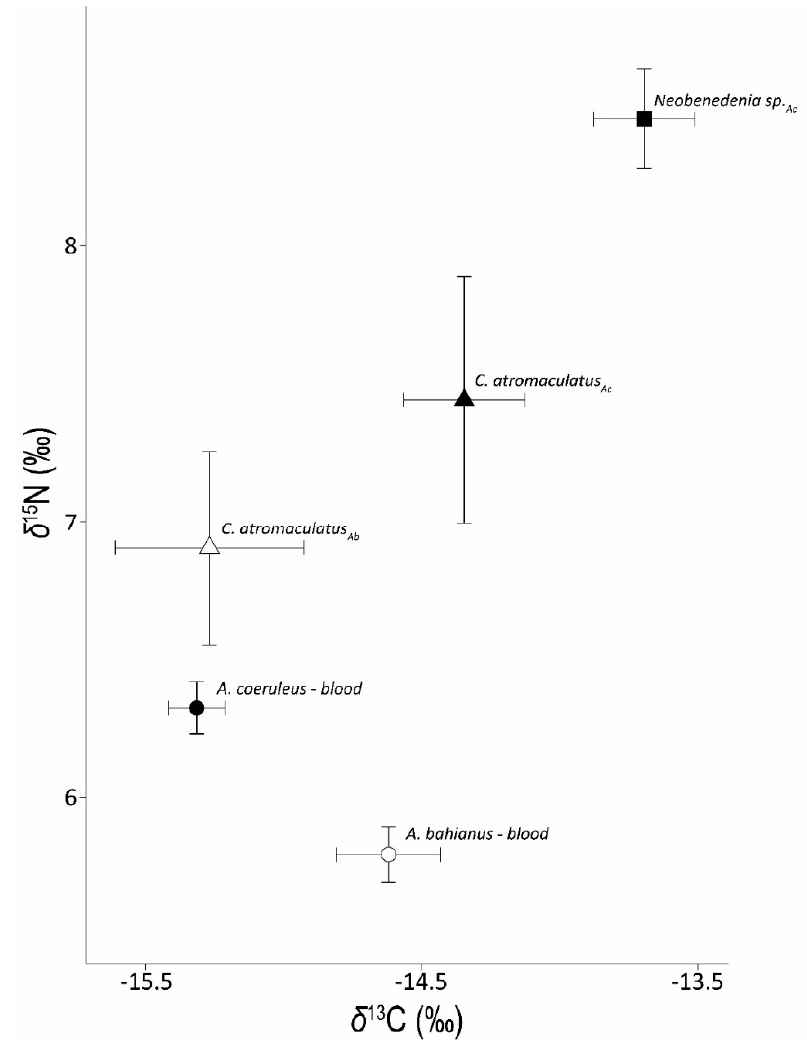
Figure 2. Mean ± SE δ 13 C and δ 15 N data for host fish blood (circles) and associated Caligus atromaculatus (triangles) and Neobenedenia sp. (square) collected from A. coeruleus ( Ac ) and A. bahianus ( Ab ) hosts.